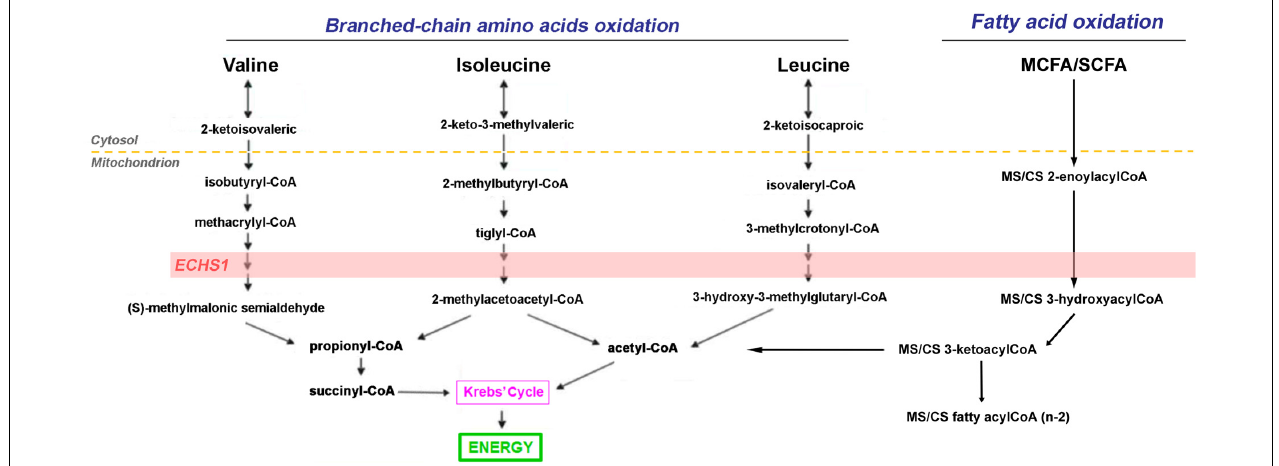
FIGURE 3 | Role of ECSH1 in branched-chain amino acids and short- and medium-chain fatty acid catabolism. The short-chain enoyl-CoA hydratase ECHS1 has a critical role in branched chain amino acid (BCAA) catabolism as well as fatty acid catabolism generating succinyl-CoA and acetyl-CoA which are fed into the Krebs’ cycle for the generation of reducing